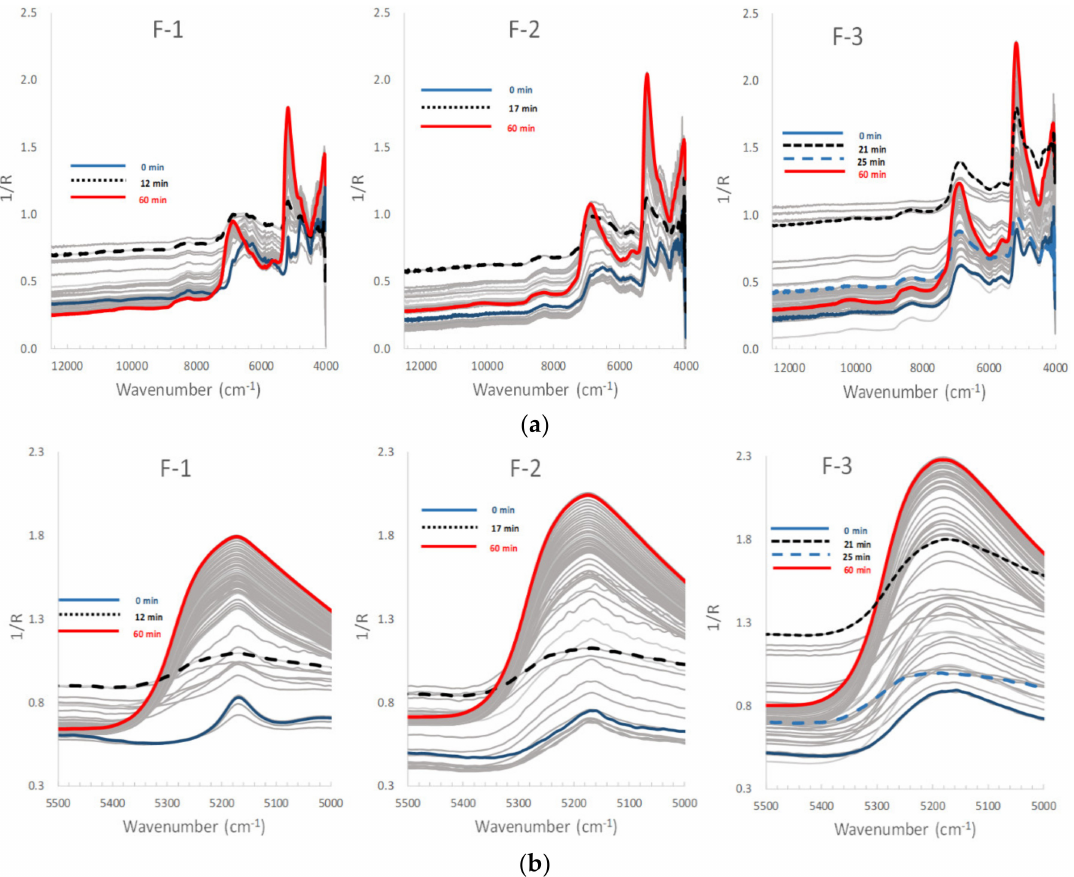
Figure 3. ( a ) Near-infrared spectral changes in the model powder formulations wet granulation processes using the high-speed shear wet granulator. ( b ) Near-infrared spectral changes (5500–5000 cm − 1 ) in the model powder formulations during wet granulation processes using the high-speed shear wet